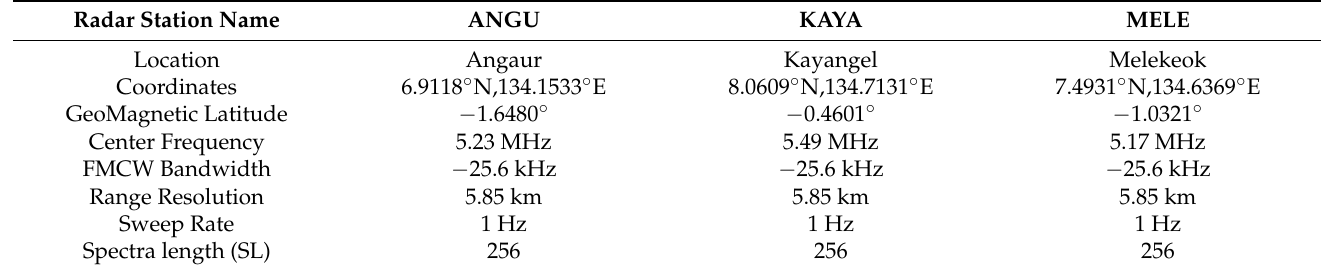
Figure 1. Map of HFR locations in Republic of Palau. Operating specifications for the HFRs are listed in Table 1. Table 1. Location and parameters for the Republic of Palau HFR Observatory.